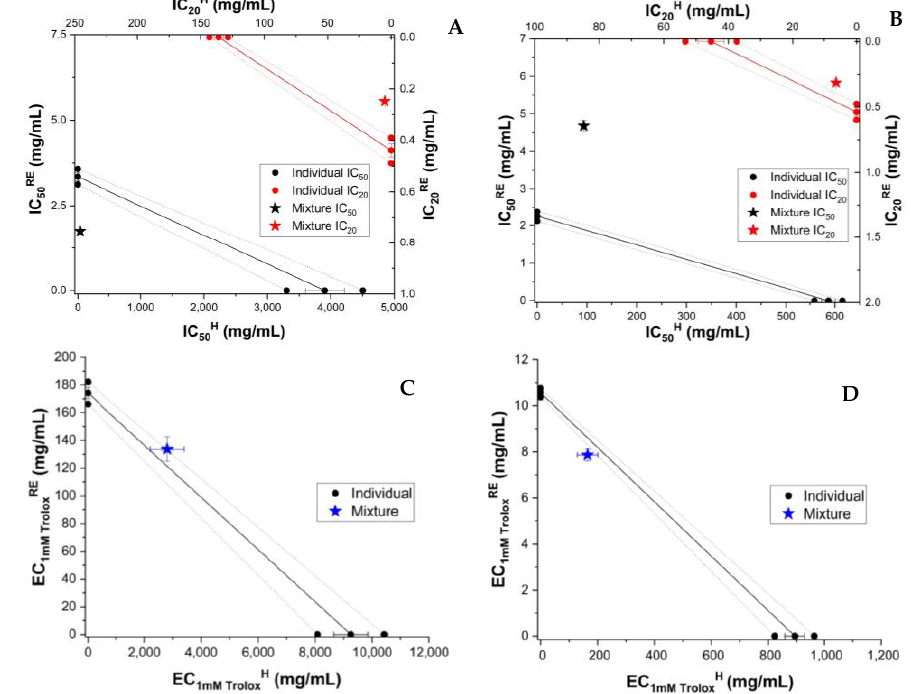
Figure 1. Isobolograms of honey (H) and raspberry extract (RE) based on IC 50 (half-maximal inhibitory concentration) and IC 20 (inhibitory concentration at 20% substrate inhibition) for DPPH ( A ), and ABTS ( B ) methods, and based on EC 1mM Trolox (effective concentration at 1 mM Trolox equivalent of the samples) for CUPRAC ( C ) and FRAP ( D ) methods. The error bars from three measurements are shown for each value. Confidence intervals at 95% confidence are shown by dashed lines.